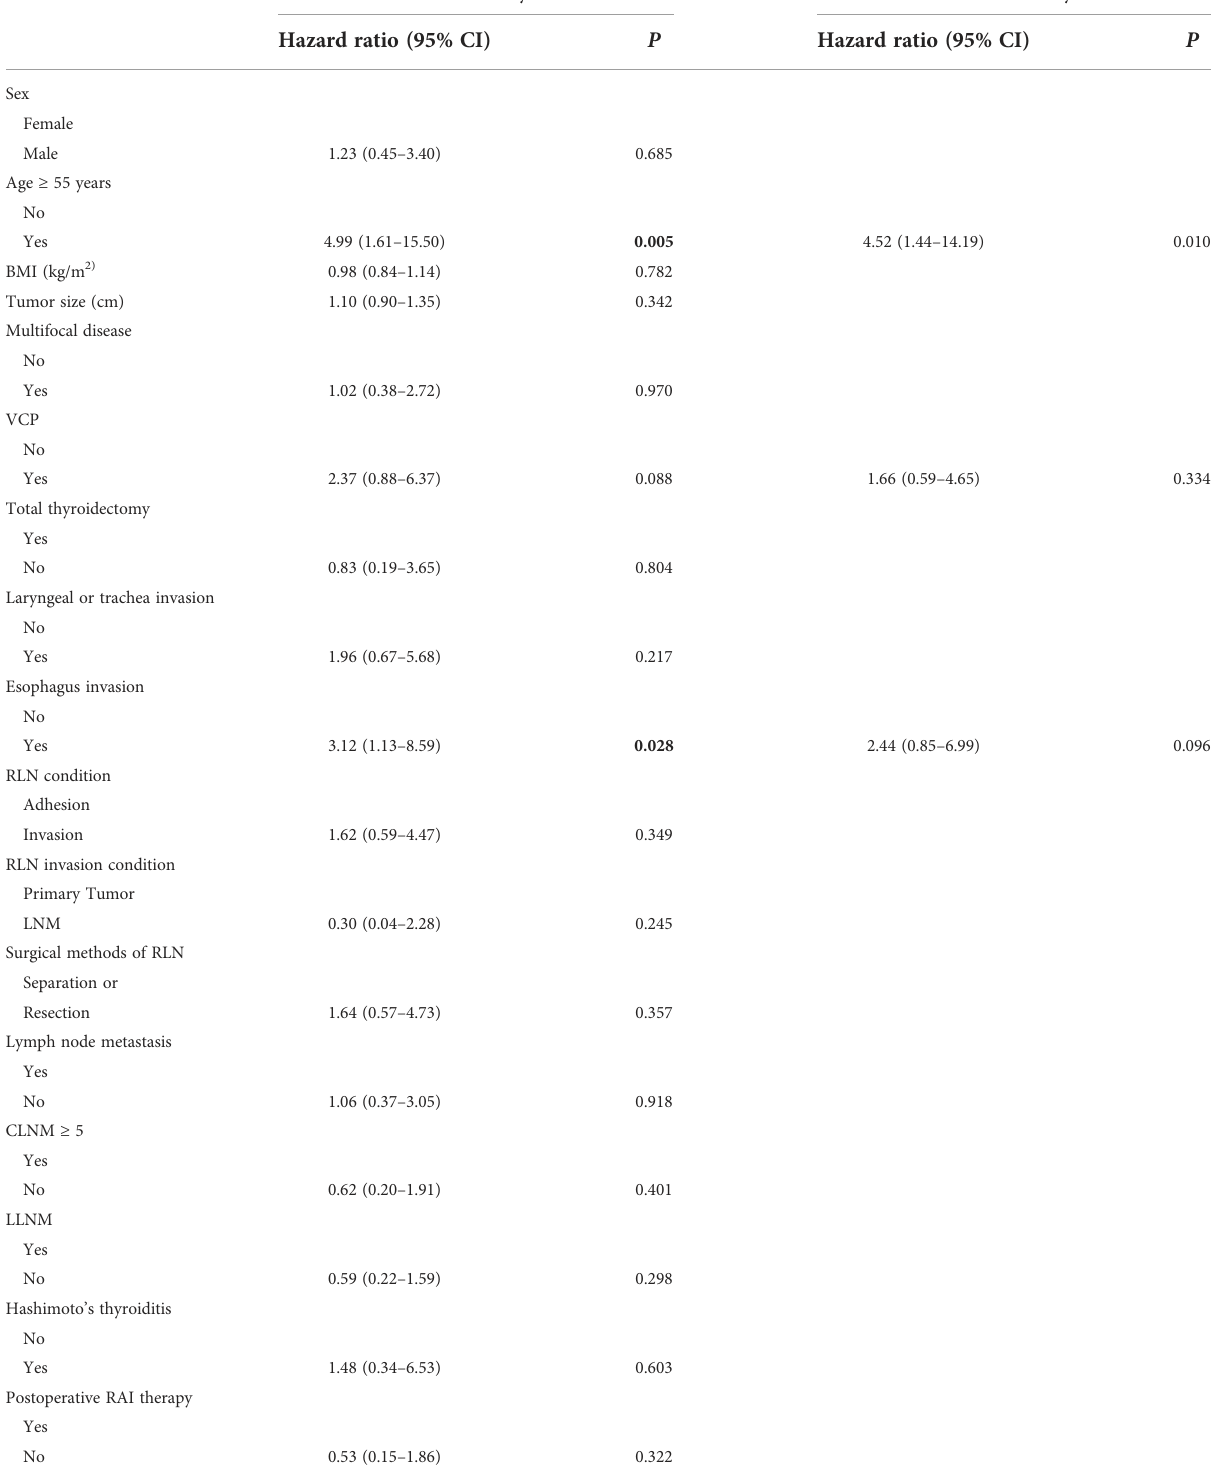
TABLE 5 Univariable and multivariable Cox proportional hazards regression analyses of the risk of